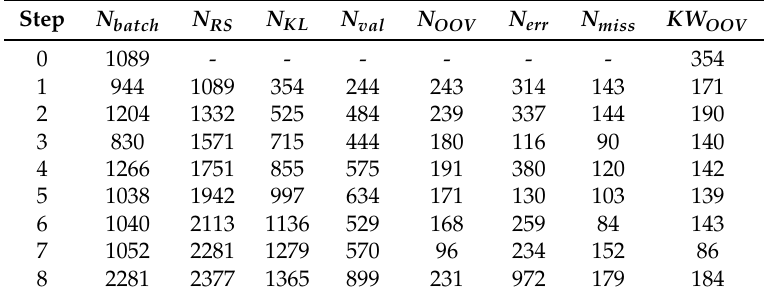
Table 3. Word images processed by the KWS system step by step. Note that at step 8, batch 8 and batch 9 have been merged in one single batch.